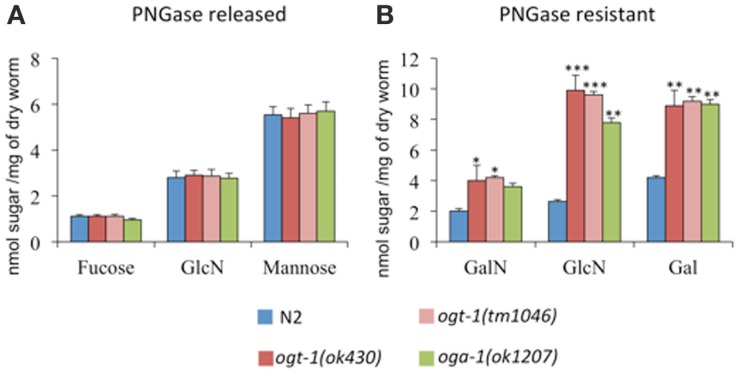
C. elegans lacking OGT-1 and OGA-1 activity show increased GalN, GlcN, and Gal monosaccharides compared to N2 animals (B). Concentrations of monosaccharides galactosamaine (GalN) and glucosamine (GlcN) were measured by HPAEC as, immediately following their release, the N-acetyl sugars GalNAc and GlcNAc, respectively, undergo quantitative deacetylation. No statistically different changes were observed for the composition of PNGase A and F sensitive glycans for O-GlcNAc cycling mutants when compared to N2 animals (A). Error bars represent SD of an experiment done in triplicate. ns: P > 0.05; *P < 0.05; **P < 0.005; ***P < 0.0005 compared to N2.